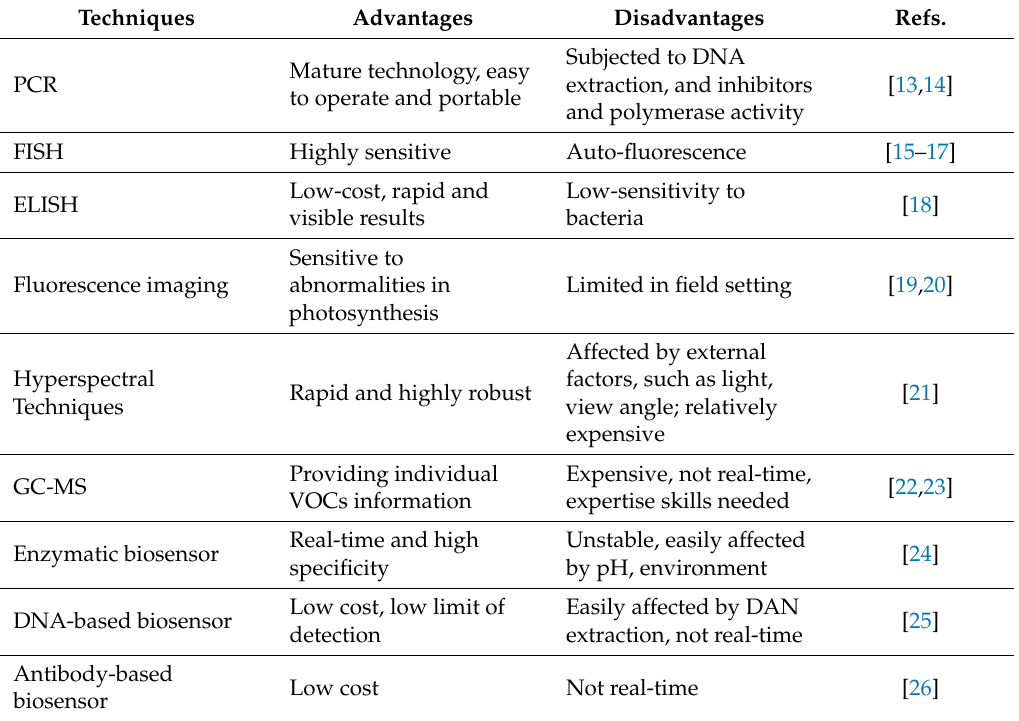
Table 1. Comparison of the typical technologies for plant disease detection. Techniques Advantages Disadvantages